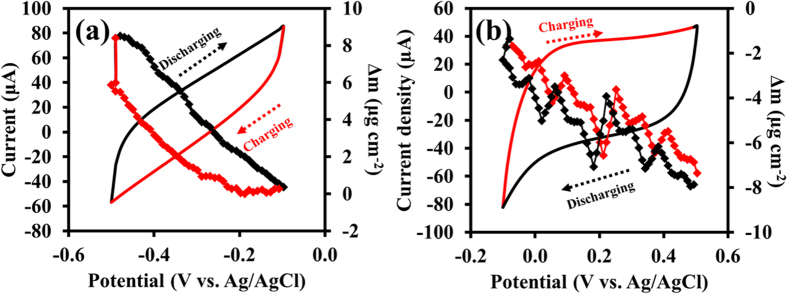
CVs at 25 mVs−1 and in situ EQCM responses of (a) N-rGOae and (b) MnO2 electrodes.